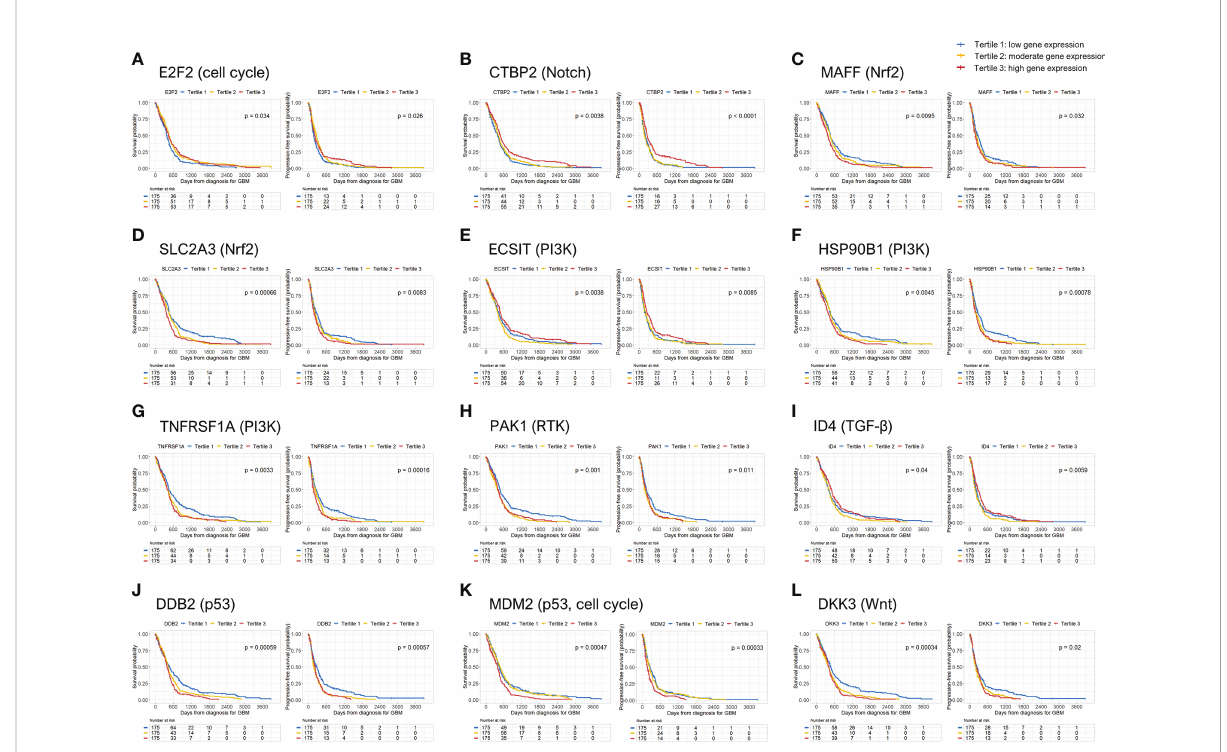
FIGURE 1 Overall survival (OS) and progression-free survival (PFS) rates according to 12 genes signi fi cantly associated with mortality and disease progression in GBM patients. GBM,